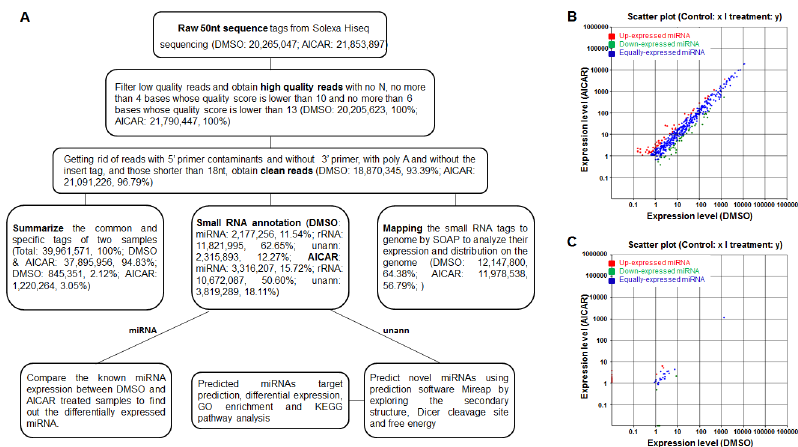
Figure 1. Overview of sRNA high-throughput sequencing data. (A) A flowchart that shows stepwise data analysis process of small RNA reads from Solexa Hiseq sequencing. (B) Comparison of the known miRNA expression between DMSO- and AICAR-treated samples; the scatter plot shows differentially expressed miRNAs in the two samples. (C) Comparison of the predicted novel miRNA expression between DMSO- and AICAR-treated samples; the scatter plot shows differentially expressed miRNAs in the two samples.